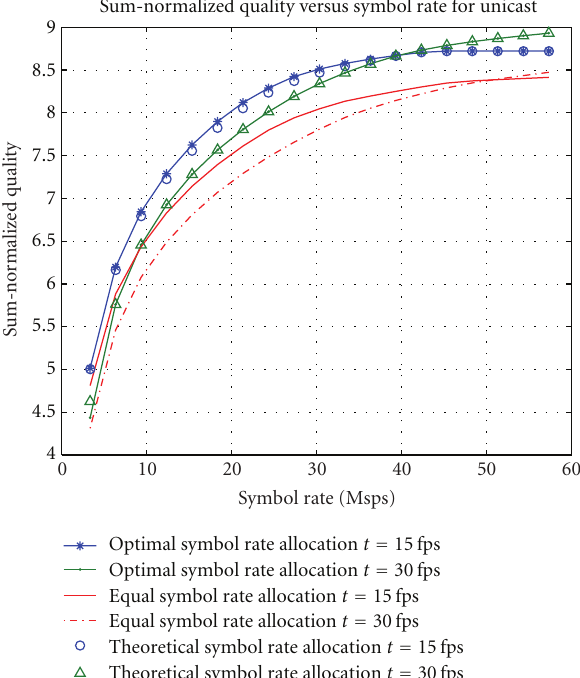
Figures 9 and 10, respectively with each shade repre- senting the portion of the DL subframe allocated to a particular video sequence belonging to the set